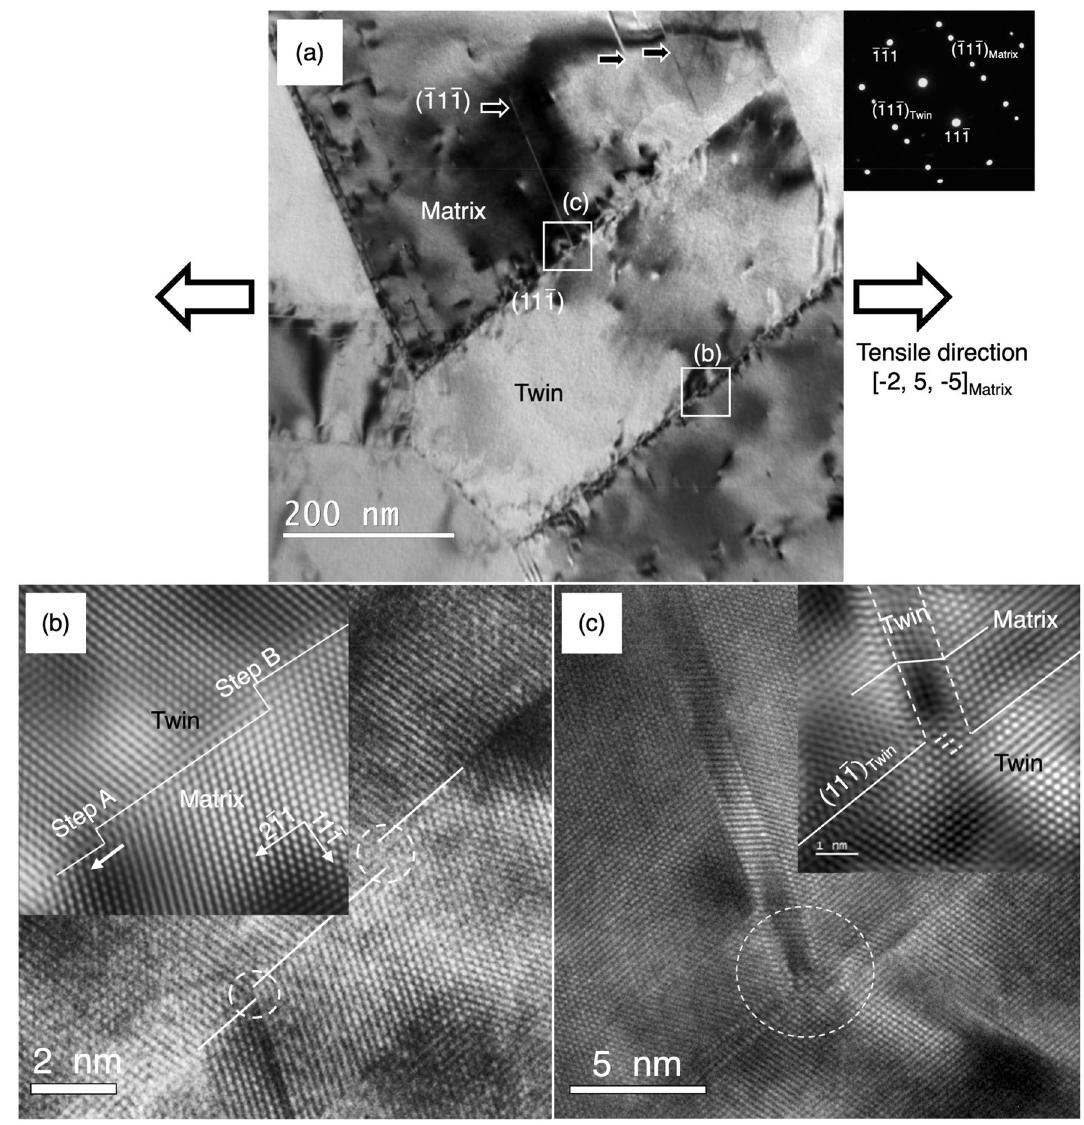
Figure 4. ( a ) BF TEM image taken in a zone axis = [011] shows the deformed microstructure and deformation twins at a Σ3{111} twin boundary. The Σ3{111} twin plane and deformation twin plane are designated to be (11 1 ) matrix and ( 1 1 1 ) matrix based on the attached inset of diffraction pattern. The tensile direction indicated by double white arrow is estimated to be [ 2 5 5 ] matrix . ( b ) HRTEM image shows two atomistic disconnections, circled by white-dotted line. The inset Fourier-filtered HRTEM image corresponding to the white-dotted lines shows two disconnections (A and B). ( c ) HRTEM image shows a deformation twin nucleated from a disconnection having 3-monolayers height at the Σ3{111} twin boundary. The inset Fourier-filtered HRTEM image corresponding to the nucleation site circled by white-dotted line shows the detailed atomic planes, the [ 2 5 5 ] matrix tensile axis causes the resolved shear stress applied on {111} 〈 112 〉 leading Shockley par- tial dislocation to be larger than those applied on {111} 〈 110 〉 perfect dislocations and {111} 〈 112 〉 trailing Shockley partial dislocations in both Σ3{111} twin plane and deformation twin plane. For example, the Schmid factor for a/6[2 1 1] leading Shockley partial dislocation gliding on (11 1) planes is as high as 0.488, i.e., twice larger than that for the a/6[ 1 21] and the a/6[112] trailing partial dislocations, which would promote the leading Shockley partial dislocation to glide on the planes adjacent to the twin plane during plastic deformation. To probe detailed insights of how the Σ3{111} twin boundary being deformed and the origin of those localized contrasts around Σ3{111} twin boundaries, two squared regions on the Σ3{111} twin boundaries (Fig. 4a) were examined by the high-resolution TEM (HRTEM) imaging technique. Figure 4b and c are the corresponding HRTEM images taken from a [011] fcc zone axis, showing (i) atomistic steps with the height of two or three {111} lattice spacings (Fig. 4b), which are usually described as twinning dislocations with disconnection character 33,34 . We denote them as twin boundary disconnection in here (ii) a deformation twin nucleated at a step (disconnection) (Fig. 4c). A pair of experimental and Fourier-filtered HRTEM images in Fig. 4b exhibit two disconnections (A